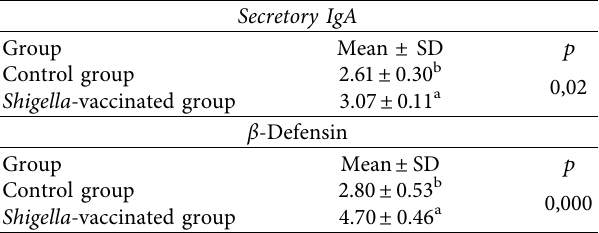
Table 2: Compared to control, the difference in secretory IgA and β -defensin is secondary to Shigella vaccination.